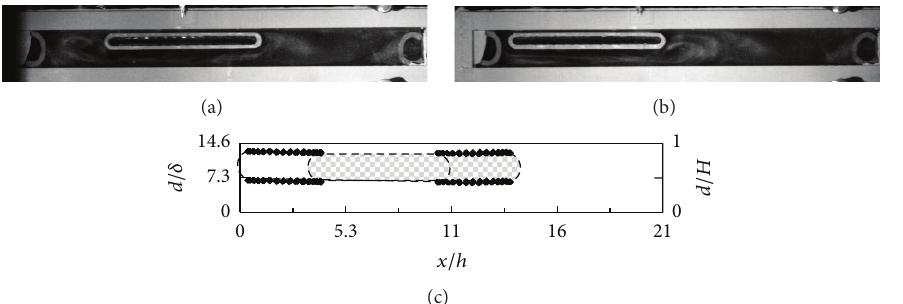
Figure 16: Flat solid position in the container during vibration ((a): left, (b): right) and the trajectory of oscillating body motion (c) during the period, 𝑓 = 15.6 Hz.